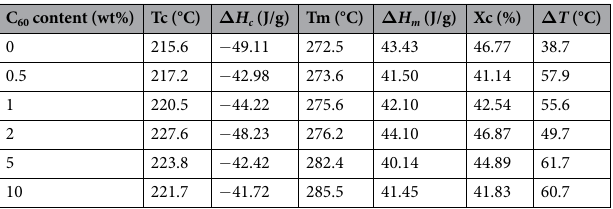
Table 2. DSC traces for PPS and PPS/C 60 .